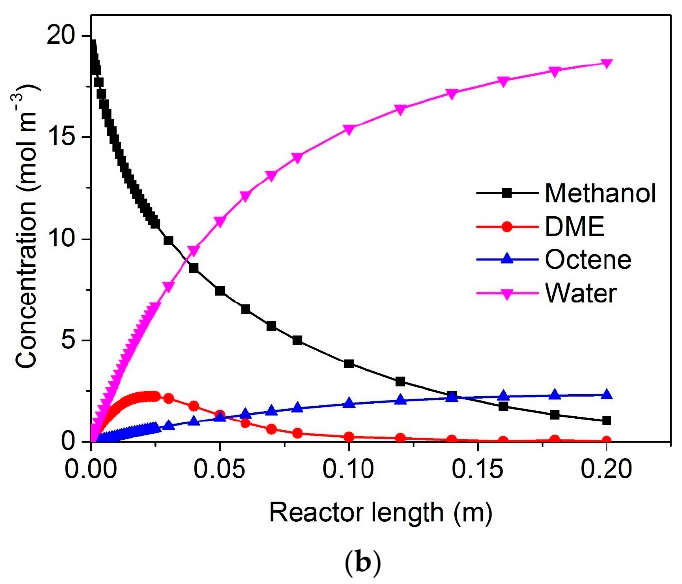
Figure 4. ( a ) Heat generation profile and ( b ) concentration profiles of the reactants and reaction products along the reactor length. Initial concentration of methanol: 18.7 mol × m − 3 , WHSV: 2.4 h − 1 ; catalyst temperature: 653 K; pressure: 1 bar.